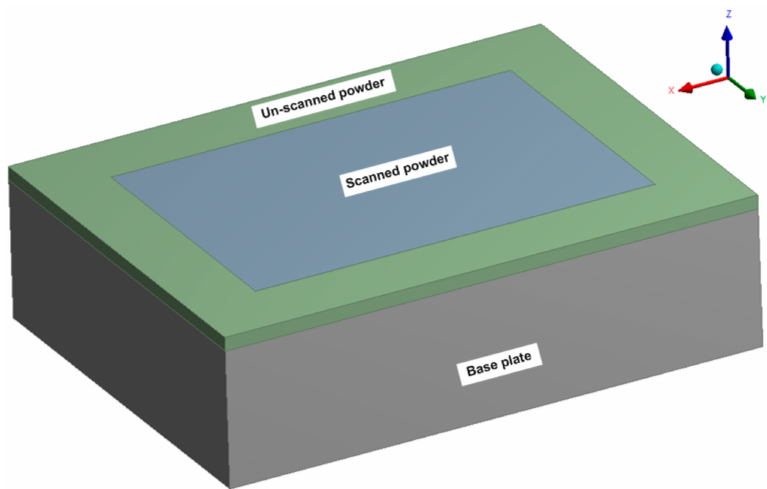
Figure 3. The model geometry used in the analysis (not to